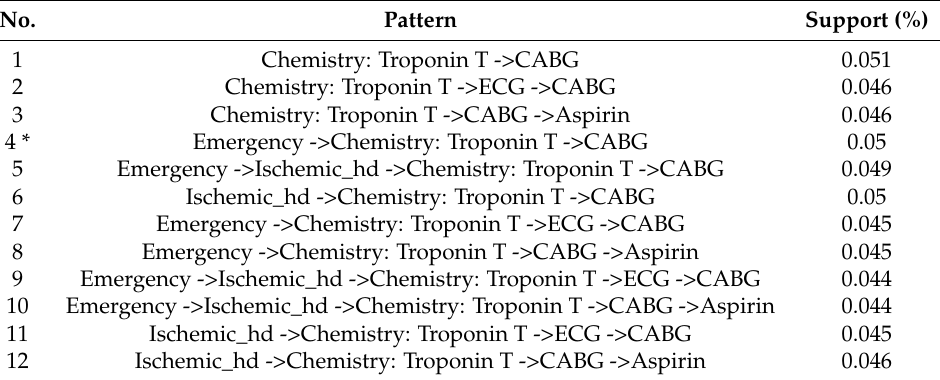
Table 3. Patterns strongly related to unplanned cardiac